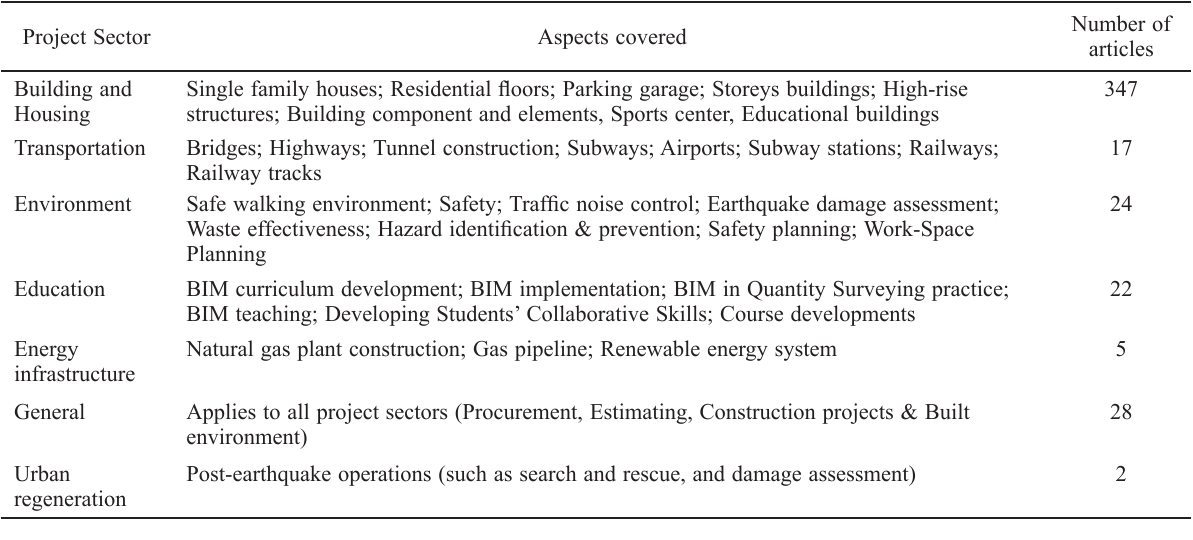
Table 9. BIM software and data schema BIM software